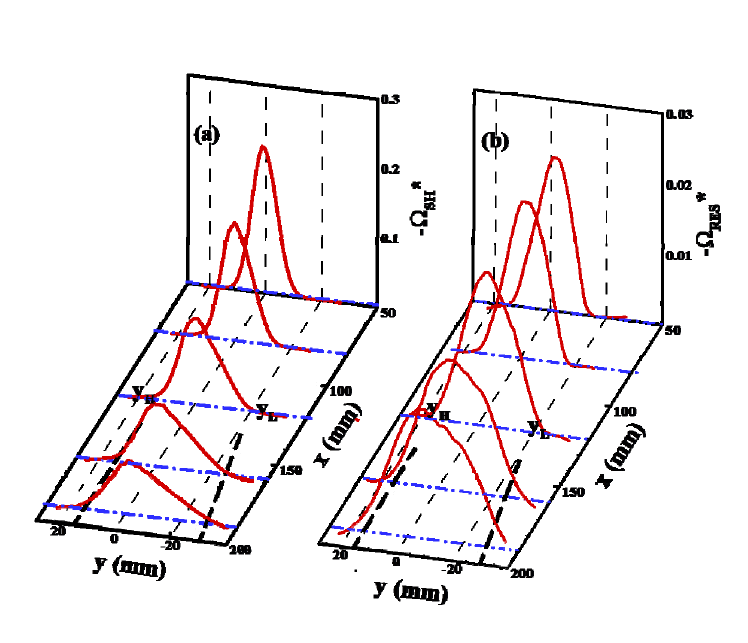
Figure 4 Evolution of the sectional profiles of the nor b) residual components of mean span-wise vorticity u and Re = 624. θ